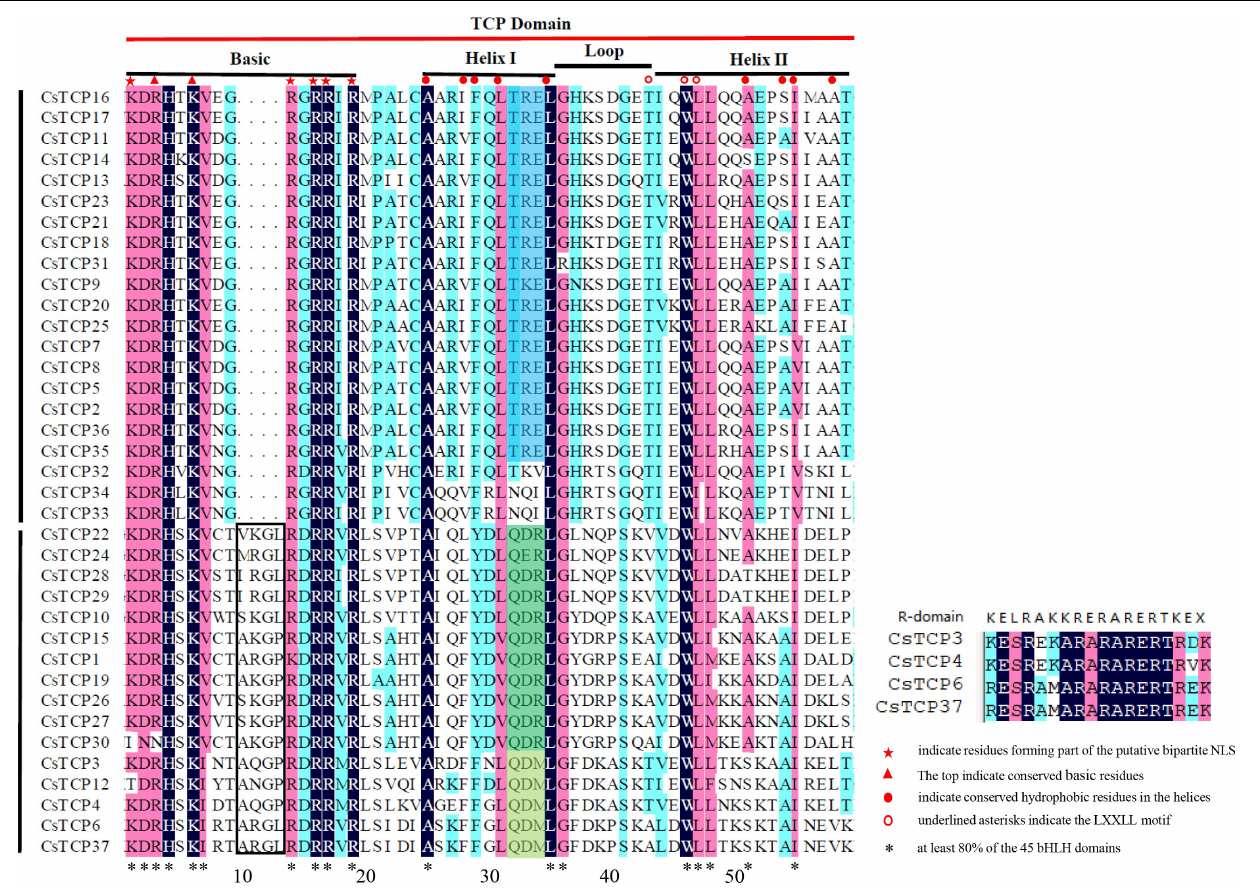
FIGURE 2 | Multiple sequence alignment and protein sequence signs of the TCP